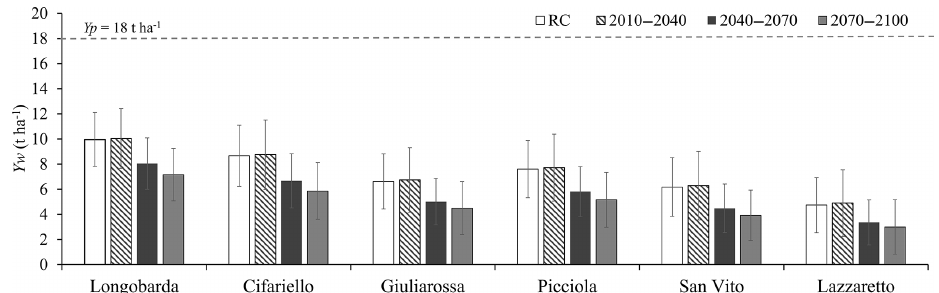
Figure 6. The projected effects of erosion on Yw for all the soil series. Other terms are explained in Fig. 2.